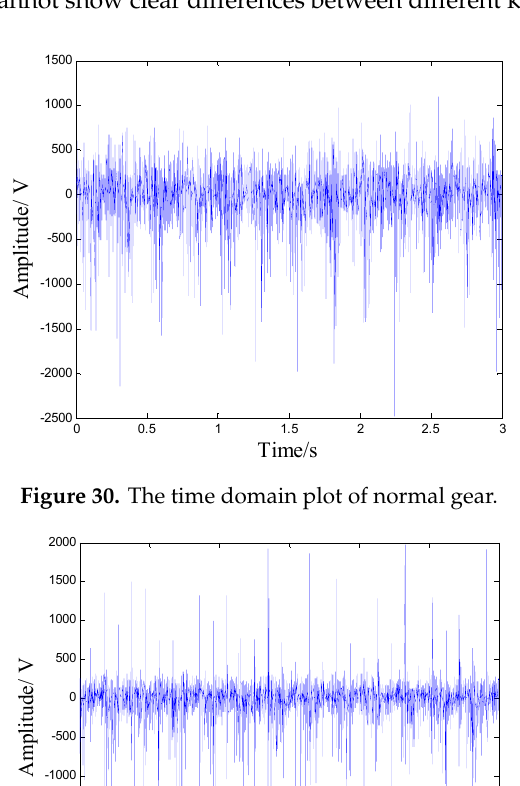
Figure 32. The time domain plot of wearing gear. Figure 33. The time domain plot of circular pitch error gear. The smooth local projection method is applied to denoise 19 groups of signals for 10 times iteration denoising, and PE values of original vibration signals and denoised vibration signals are calculated, so as to conduct fault classification. The PE values of the original vibration signals and denoised vibration signals are shown in Figure 34 and Figure 35, respectively.